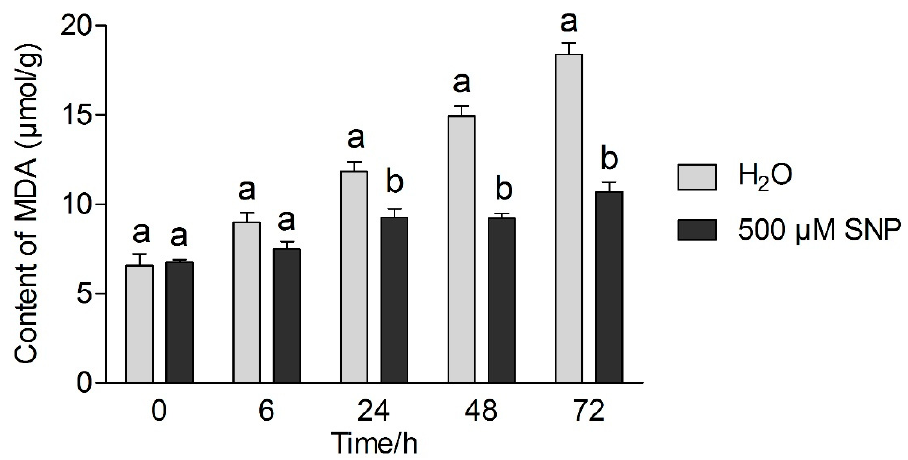
Figure 2. Effect of exogenous nitric oxide on MDA content in tea leaves under cold stress. Means with different letters have significant differences according to Dunkin’ test p <